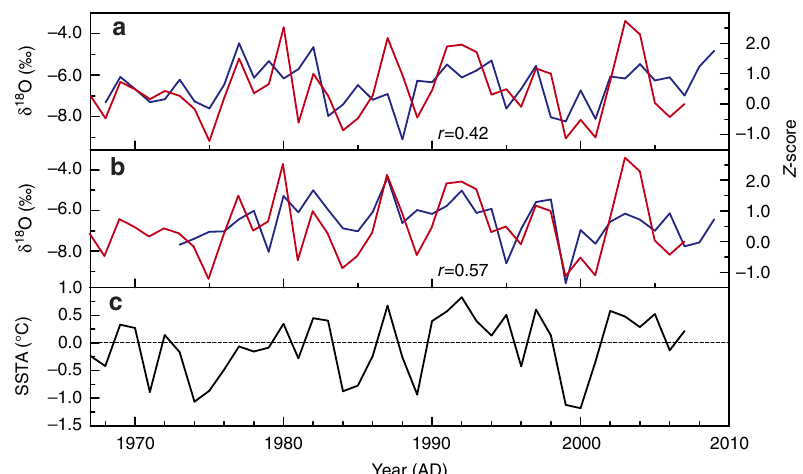
Figure 3 | Comparison between the Taiwan tree-ring d 18 O (red) and the precipitation d 18 O (blue) in the adjacent western Pacific obtained from the Global Network of Isotopes in Precipitation. ( a ) r ¼ 0.42 with Bangkok precipitation d 18 O ( n ¼ 40, P o 0.0001). ( b ) r ¼ 0.57 with Hong Kong ( n ¼ 35, P o 0.0001). These plots suggest that the Taiwan tree-ring d 18 O reflects large-scale regional hydrological signals. ( c ) NIN ˜ O4 sea-surface temperature anomaly time series (http://www.cpc.ncep.noaa.gov/products/analysis_monitoring/ensostuff/ensoyears.shtml). The horizontal line denotes 0 (cid:2) C value. SSTA, SST